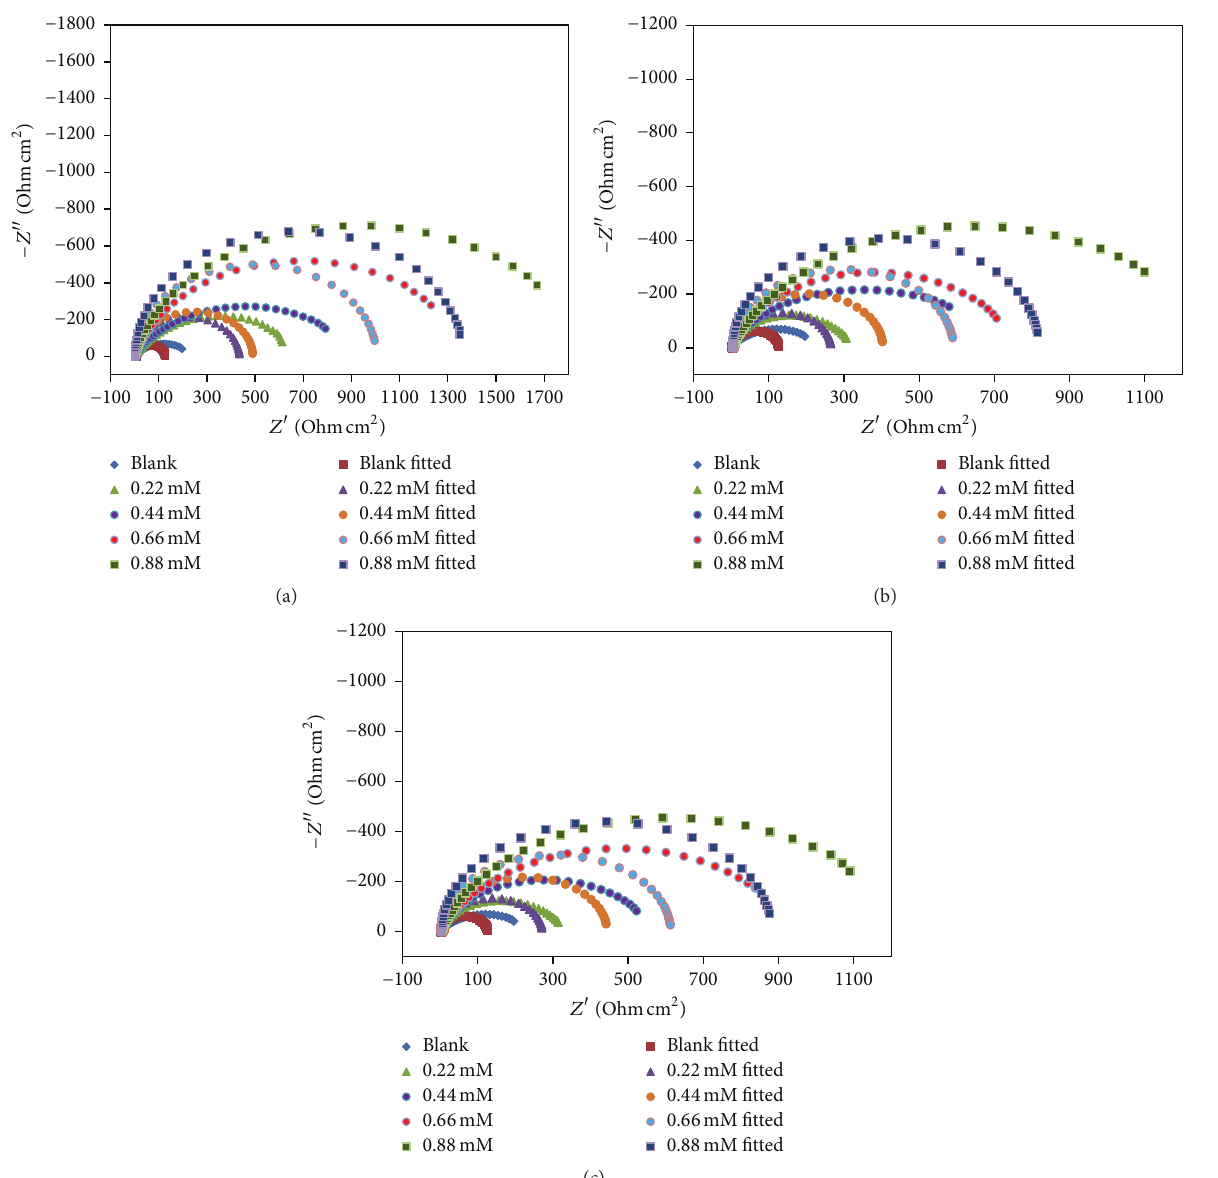
Figure 7: Nyquist plots (experimental and fitted) in the absence and presence of different concentrations of (a) 2-MTPH, (b) 3-MTPH, and (c)